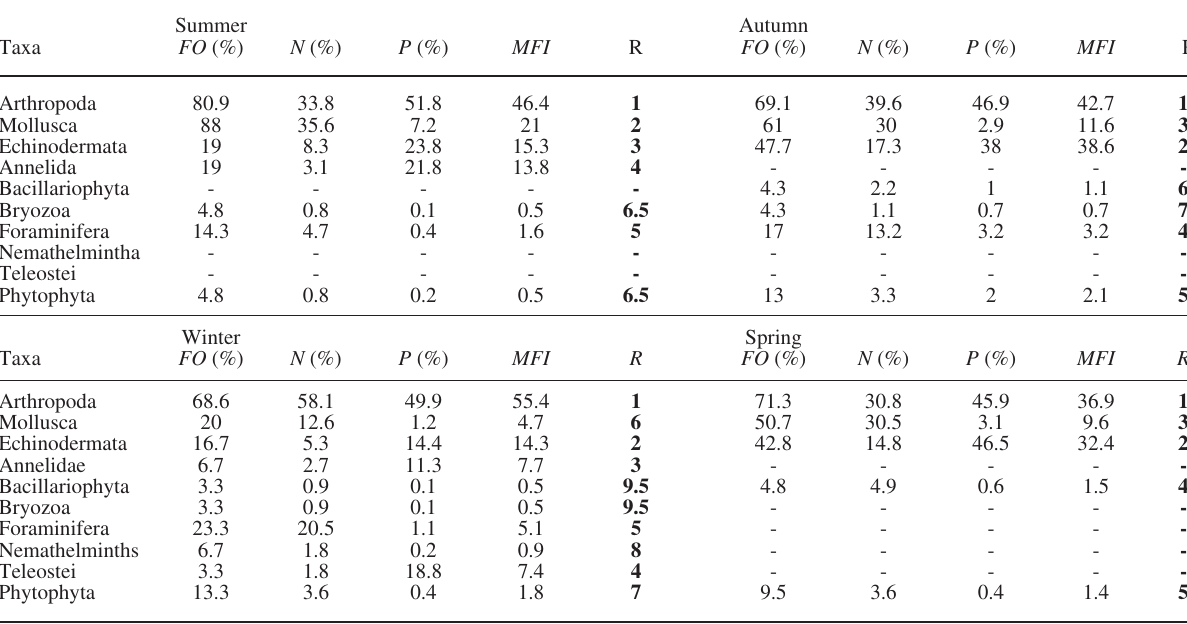
Table 7. – Prey identified in the stomach contents of P. acarne females according to season. FO , frequency of occurrence; N , numerical percentage; P , point percentage; MFI , main food index; R, classification of prey. summer autumn taxa arthropoda